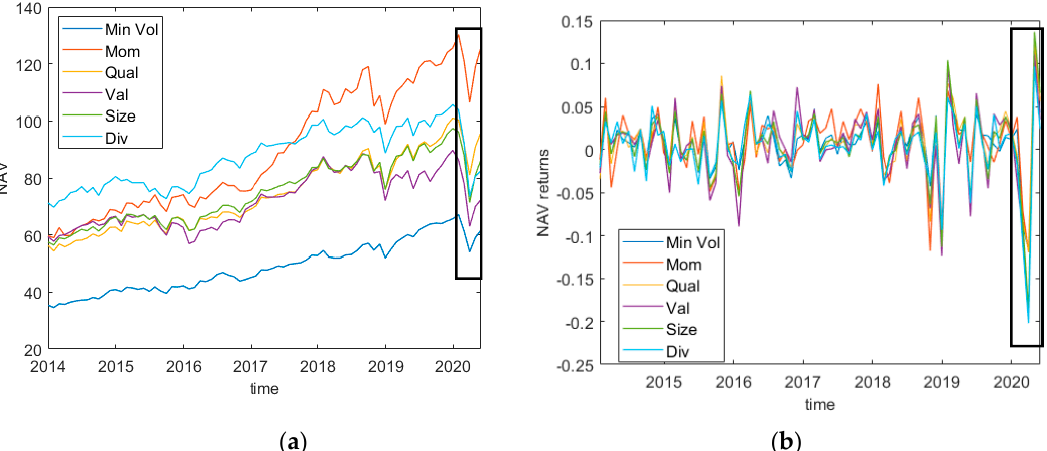
Figure 1. Monthly net asset value (NAV) in US dollars ( a ) and log returns ( b ) of smart beta products from January 2014 to May 2020. Source: Datastream.